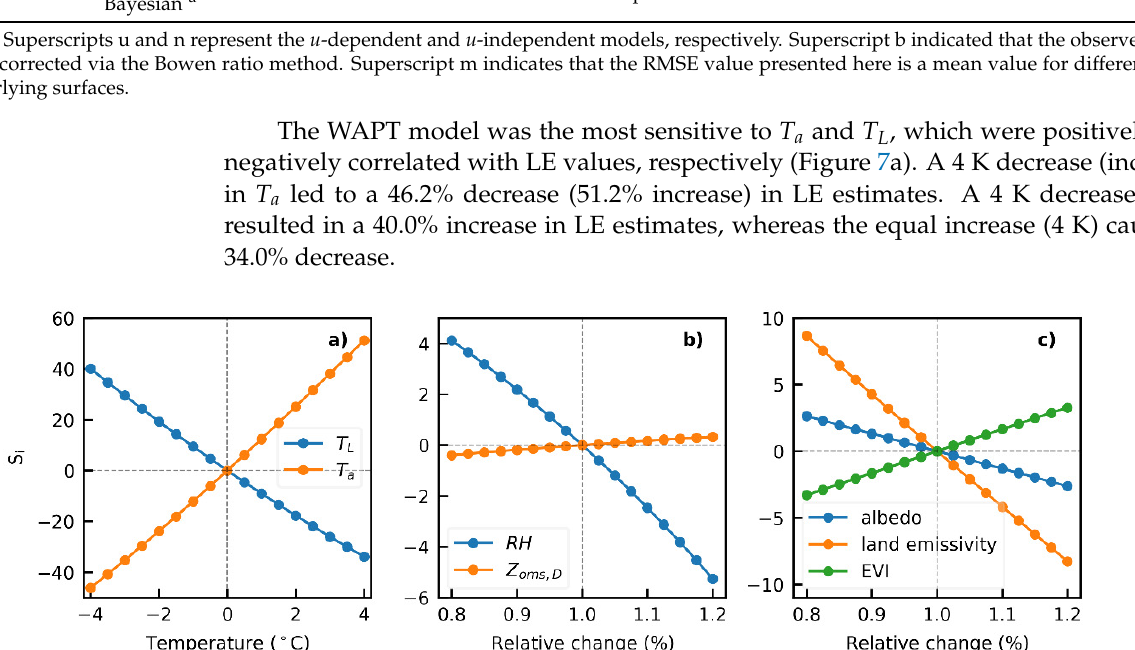
Note: Superscripts u and n represent the u -dependent and u -independent models, respectively. Superscript b indicated that the observed LE is corrected via the Bowen ratio method. Superscript m indicates that the RMSE value presented here is a mean value for different underlying surfaces.